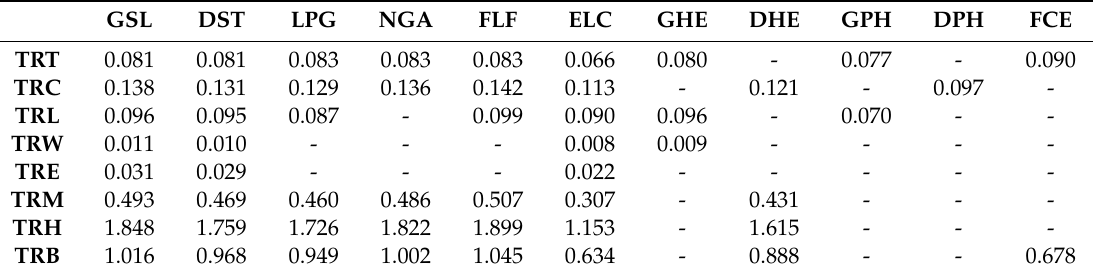
Table 8. Fixed operation and maintenance (O&M) cost (in USD/(cid:1877)(cid:1857)(cid:1853)(cid:1870) ) for the different Fixed operation and maintenance (O&M) cost (in USD/year ) for the di ff erent modes/technologies in the current road transport module. modes / technologies in the current road transport